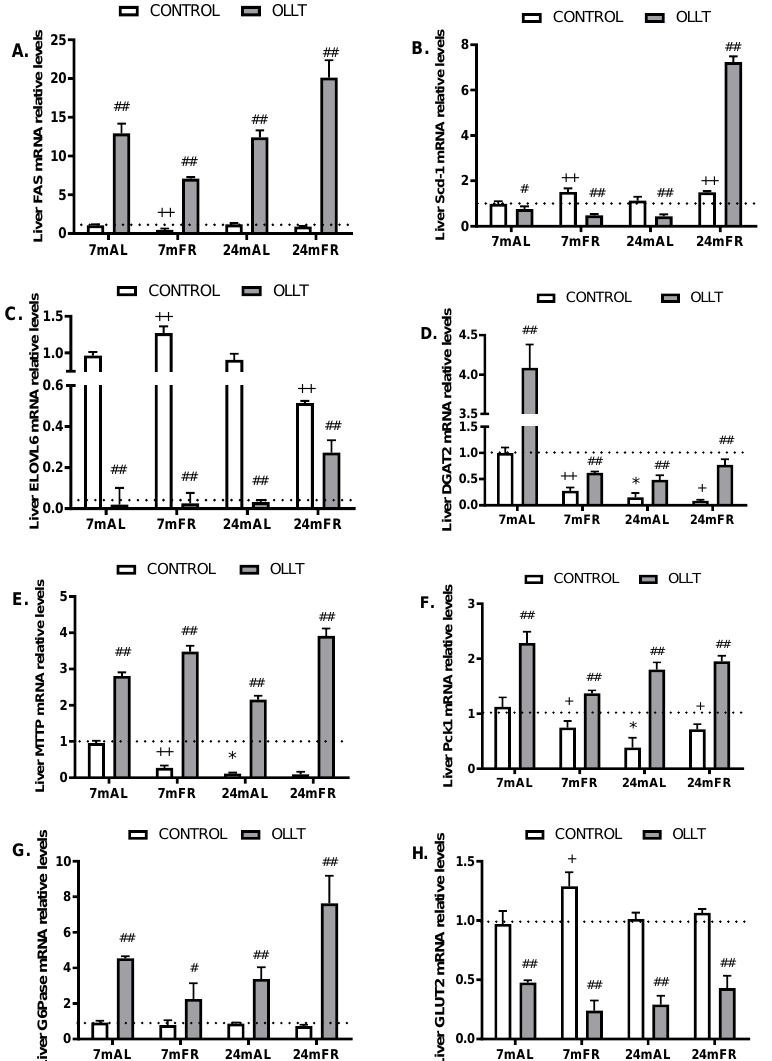
Figure 5. mRNA relative levels of FAS ( A ), Scd-1 ( B ), ELOVL6 ( C ), DGAT2 ( D ), MTTP ( E ), Pck1 ( F ), G6Pase ( G ), GLUT2 ( H ) in the liver in 7 and 24-month old rats fed ad libitum (AL) or food-restricted (FR), before (CONTROL) and after an oral lipid loading test (OLLT). Results are the mean ± SEM of 8–10 rats per group, conducted in duplicates. Unpaired Student’s t -test, * p < 0.05 compared to the 7-month-old rats under the same feeding protocol; + p < 0.05, ++ p < 0.0001 compared to the age-matched ad-libitum-fed rats; # p < 0.05, ## p < 0.0001 compared to the basal levels before a fat load of the age-matched rats under the same feeding protocol.